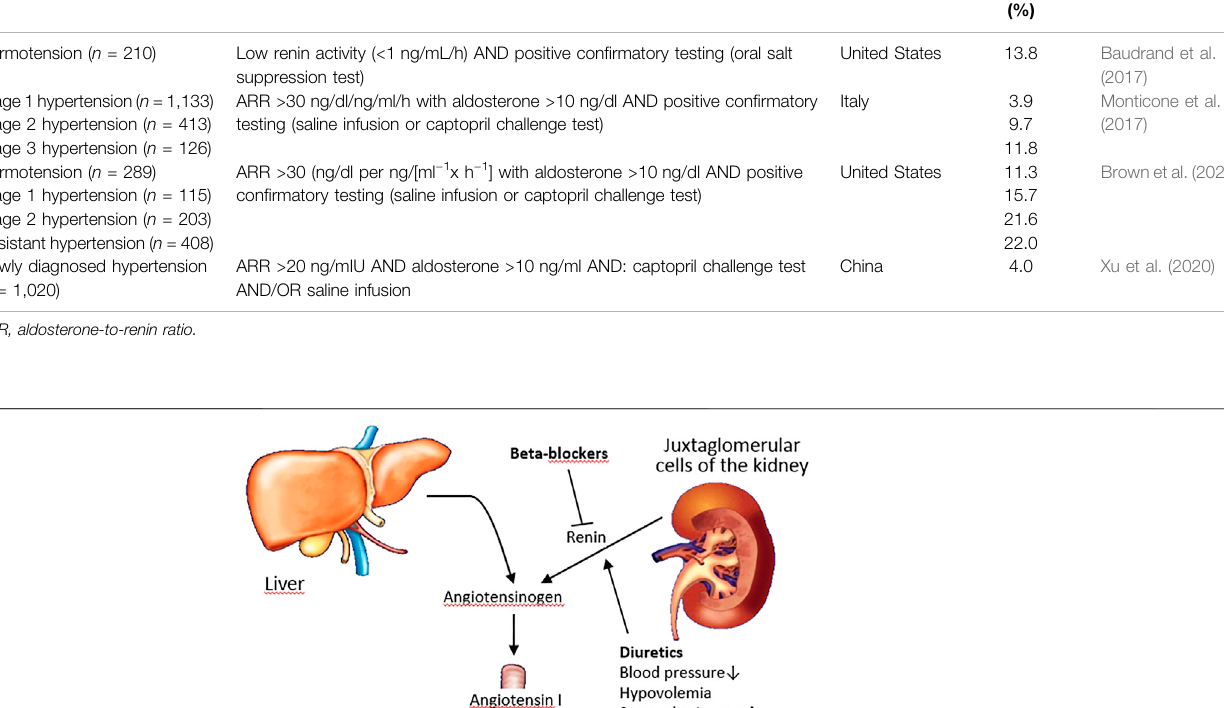
TABLE 1 | Recent studies on the prevalence of primary aldosteronism in subjects without convincing indications for screening (modi fi ed after (Hundemer et al., 2021)). Study population (n)